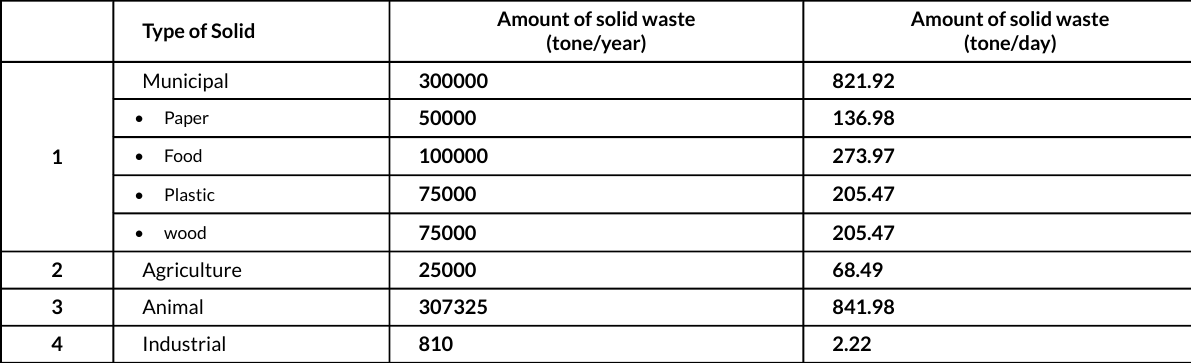
Table II. types and rates of solid produced waste in Ha’il